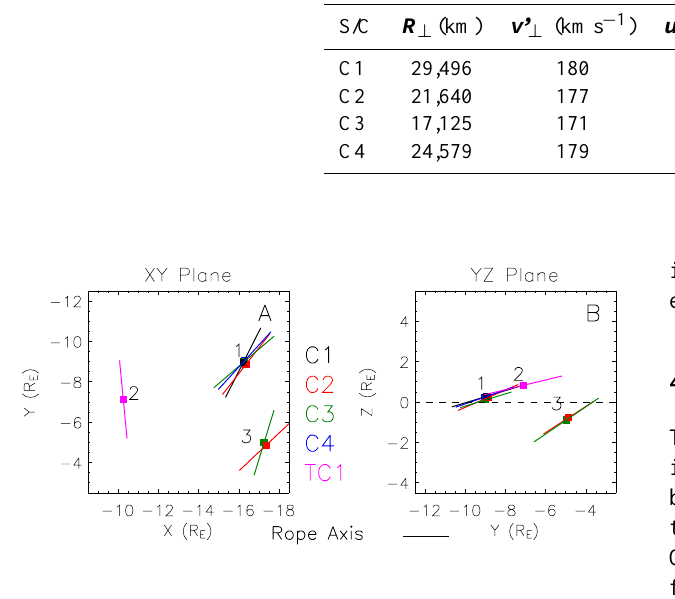
Fig. 7. A comparison of the various spacecraft positions (coloured squares – colours as for Figs. 1 and 2) and flux rope axis orienta- tions (solid lines). Spacecraft positions are in GSM. The coordinate system used for flux rope axis directions is a rotation of GSM such that the XZ plane contains the normal to the tail current sheet, rather than the Earth’s magnetic dipole axis. Signature 3 is offset by (–1, 4, –1) R E for